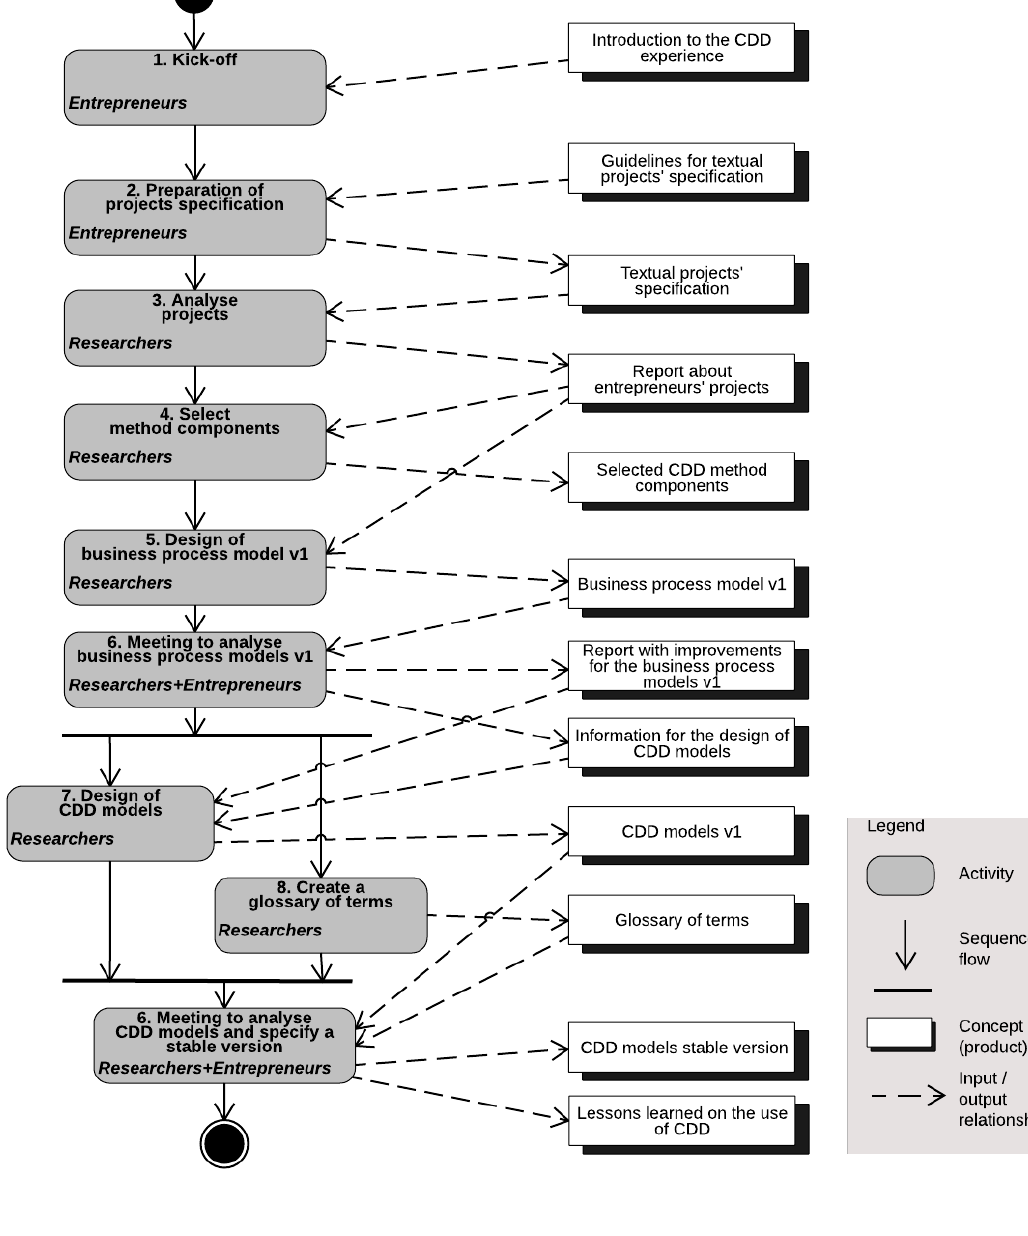
Figure 3. CDD application procedure for the two start-up